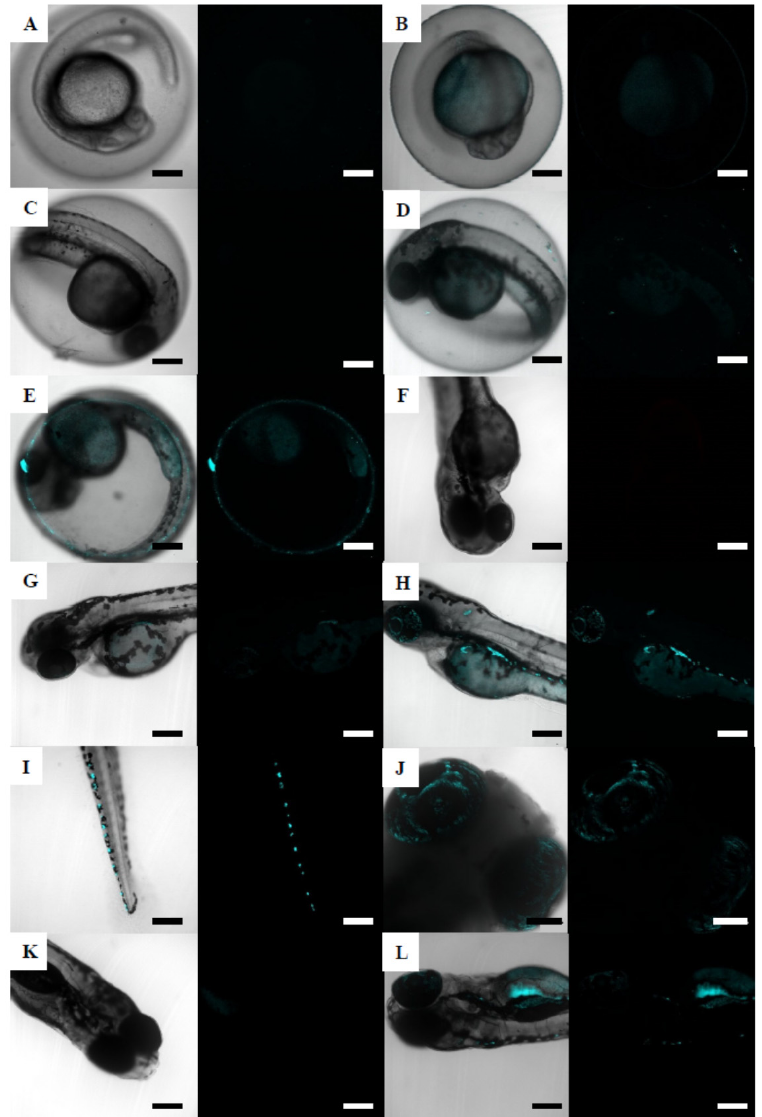
Figure 4. Confocal micrograph stacks of zebrafish embryos exposed to fluorescent 50 nm NPs. ( A ) unexposed control embryo at 24 hpf; ( B ) 24 hpf embryo exposed to 6.87 mg/L NPs; ( C ) unexposed control embryo at 48 hpf; ( D ) 48 hpf embryo exposed to 0.687 mg/L NPs; ( E ) 48 hpf embryo exposed to 6.87 mg/L NPs; ( F ) unexposed control embryo at 72 hpf; ( G ) 72 hpf embryo exposed to 0.069 mg/L NPs; ( H ) 96 hpf embryo exposed to 6.87 mg/L NPs; ( I ) 96 hpf embryo exposed to 6.87 mg/L; ( J ) 96 hpf embryo exposed to 6.87 mg/L; ( K ) unexposed control embryo at120 hpf; ( L ) 120 hpf embryo exposed to 0.069 mg/L. Scale bars: 200 µm ( A – I , K , L ) and 100 µm ( J ). The 48 hpf embryos exposed to 6.9 mg/L of 50 nm NPs or 500 nm NPs did not show